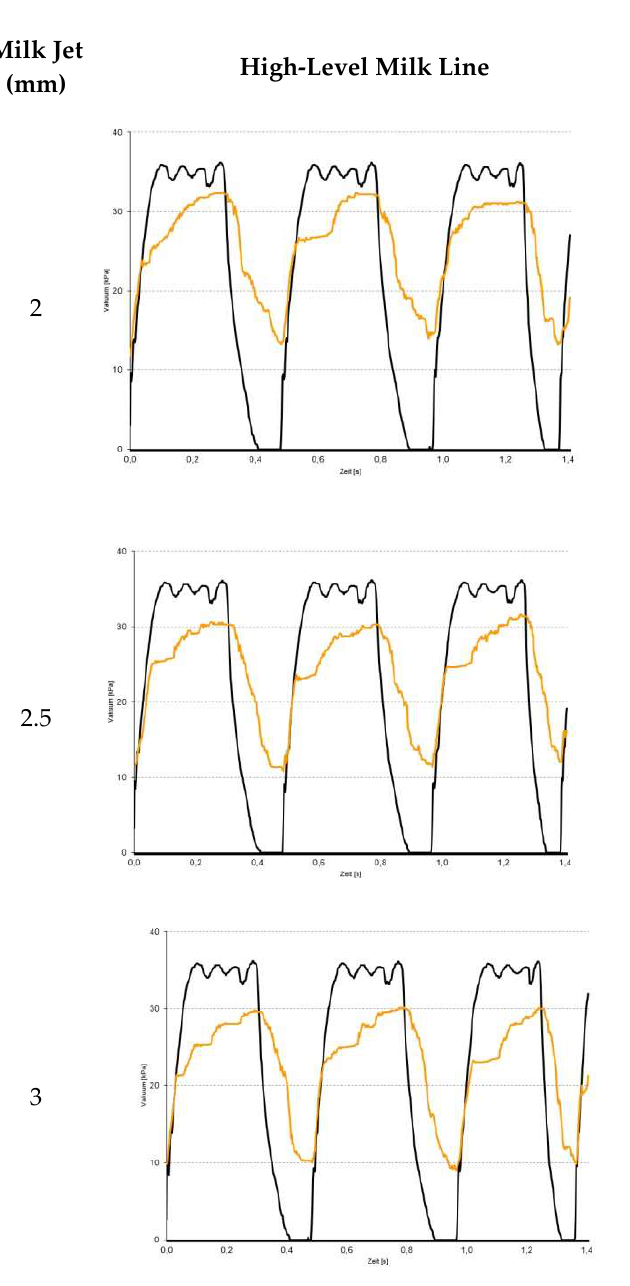
Figure 1. Cyclical vacuum fluctuations in the pulsation and inner chambers of the teat cup during milking the 1st WF in the sheep milking machine with the following settings: 34 vacuum level (kPa), 120 pulsation rate (cycles/min) and 60:40 pulsation ratio.